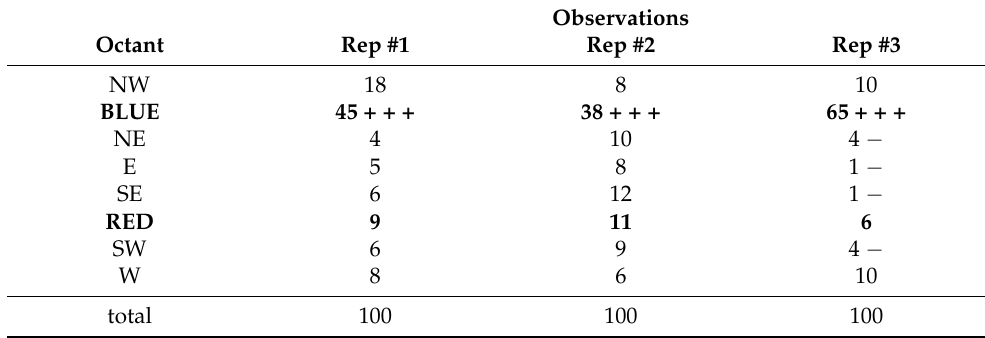
Table 7. Movements of beetles to octants. Experiment #3. Coding as − : p ≤ 0.05, +++: p ≤ 0.001. Plus signs represent overrepresentation; minus signs indicate